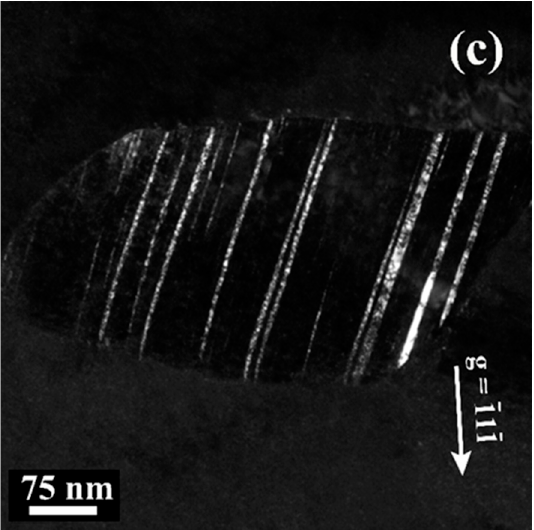
Figure 10. ( a ) Bright field and ( c ) dark field TEM images showing the formation of deformation nano-twins in a specimen tested at 200 °C to an elongation of 30%. ( b ) The SADP from the area marked by dotted circle in ( a ). The beam direction for the austenite matrix and the twinned area are B = [011] and [011] , respectively. γ : from austenite phase, γ T: from deformation twins.